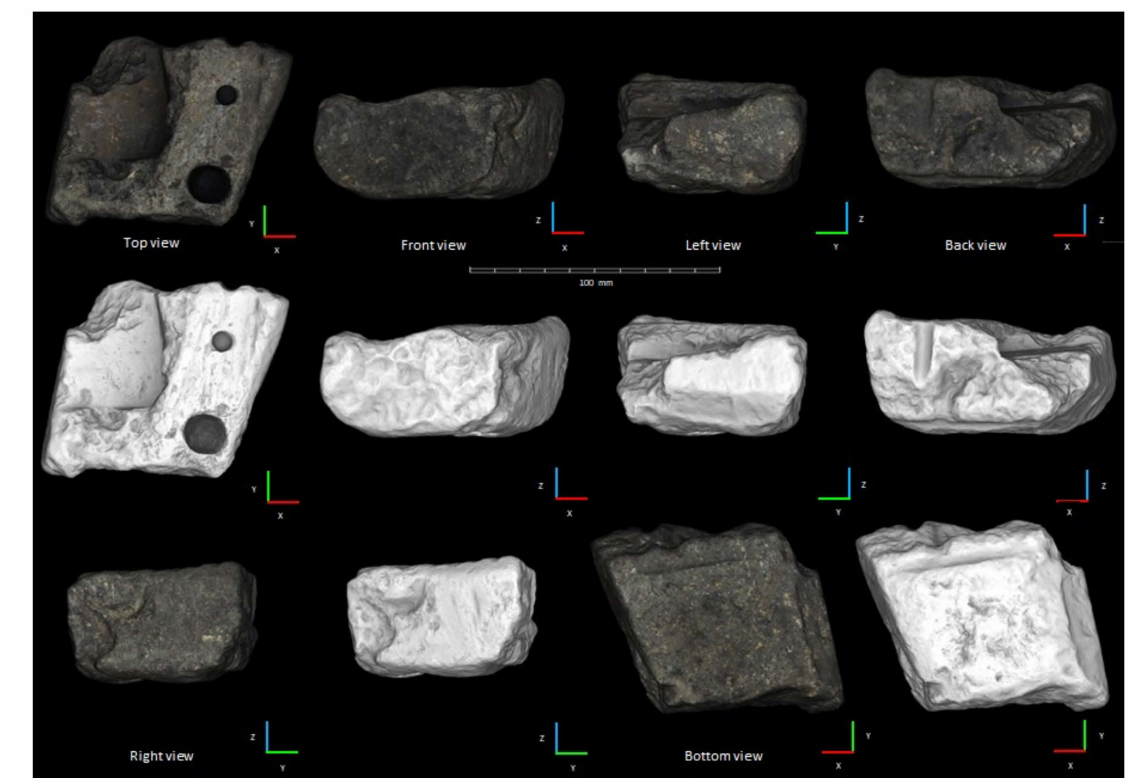
Figure 11. Orthoviews from B1 3D model, with texture and Shade Vis Plug-in; visualization with CloudCompare